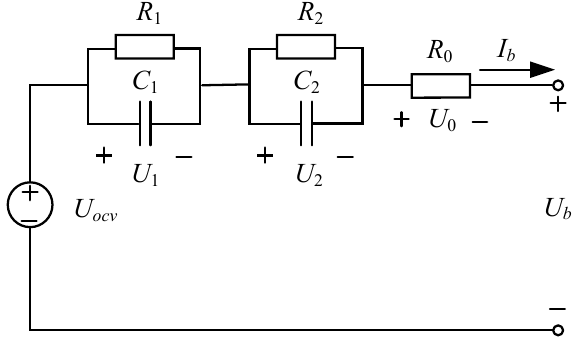
Figure 1. Second-order equivalent circuit model